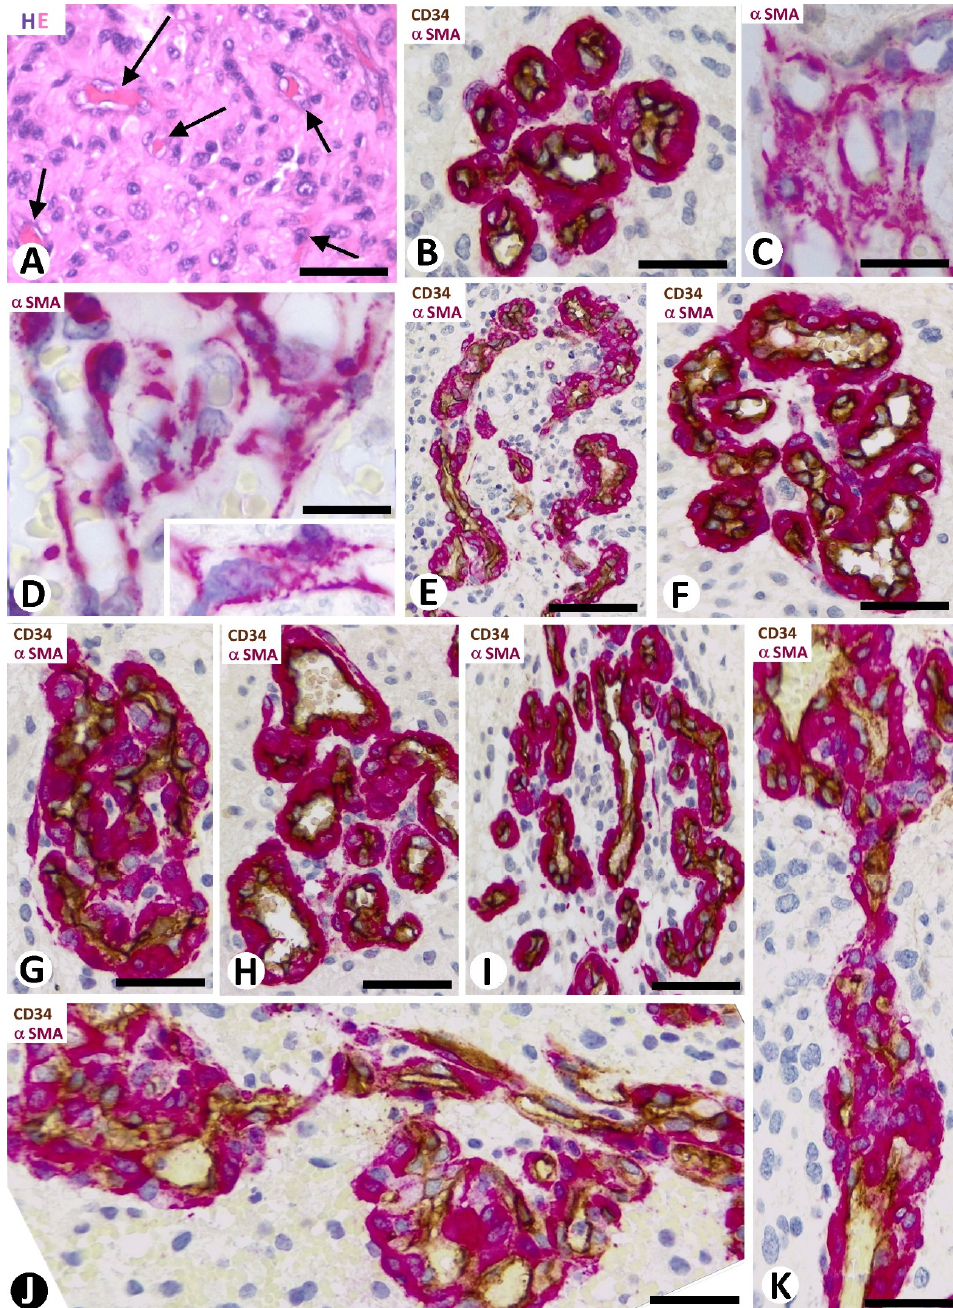
Figure 1. Vascular patterns and transitional structures in GBM. ( A ) “Classic” pattern with delicate capillaries (arrows). ( B – G ) Patterns of vascular clusters ( B – D ), vascular garlands ( E ), and glomeruloid bodies ( F , G ), which form the bizarre microvasculature (BM). In vascular clusters, note the different characteristics of pericytes (red) in Type I ( B ) or Type II ( C , D ) BM. ( H , I ) Transitional structures between vascular garlands and glomeruloid bodies. ( J , K ) Glomeruloid bodies are observed originating from vessels of varying size and transitional structures. ( A ) Hematoxylin staining. ( B , E – K ) Double immunochemistry for CD34 (brown, vascular endothelium) and α SMA (red, pericytes). Hematoxylin counterstain. ( C , D ) Immunochemistry for α SMA. Hematoxylin counterstain. Bars: ( A ) 150 µm, ( B – D , F , J , K ) 40 µm, and ( E , G –I) 45 µm .